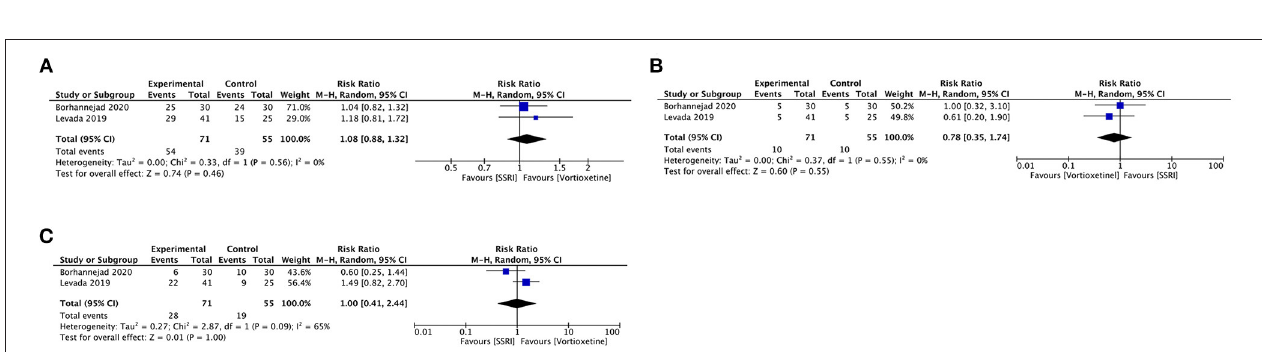
FIGURE 6 | Forest plot of comparison on vortioxetine vs. SNRIs (A) Response, (B) remission, (C) tolerability, and (D) acceptability.